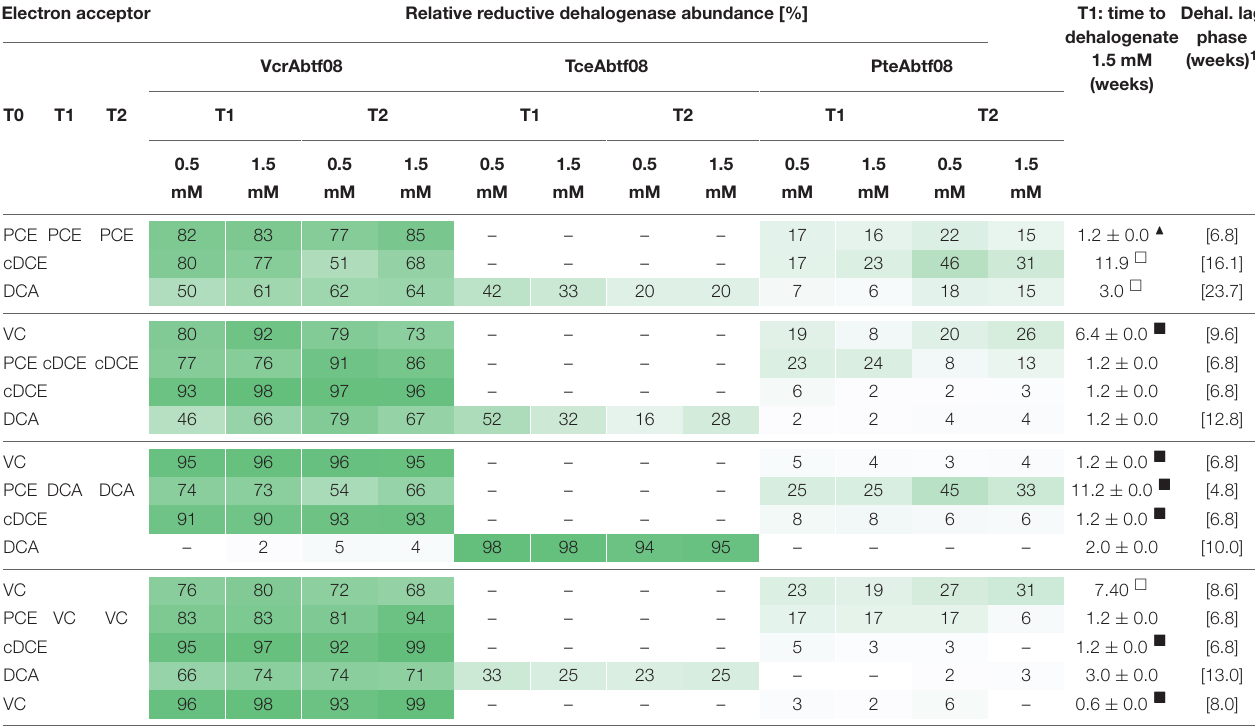
TABLE 1 | Expression of reductive dehalogenase homologous proteins (RdhA). Electron acceptor Relative reductive dehalogenase abundance [%] T1: time to